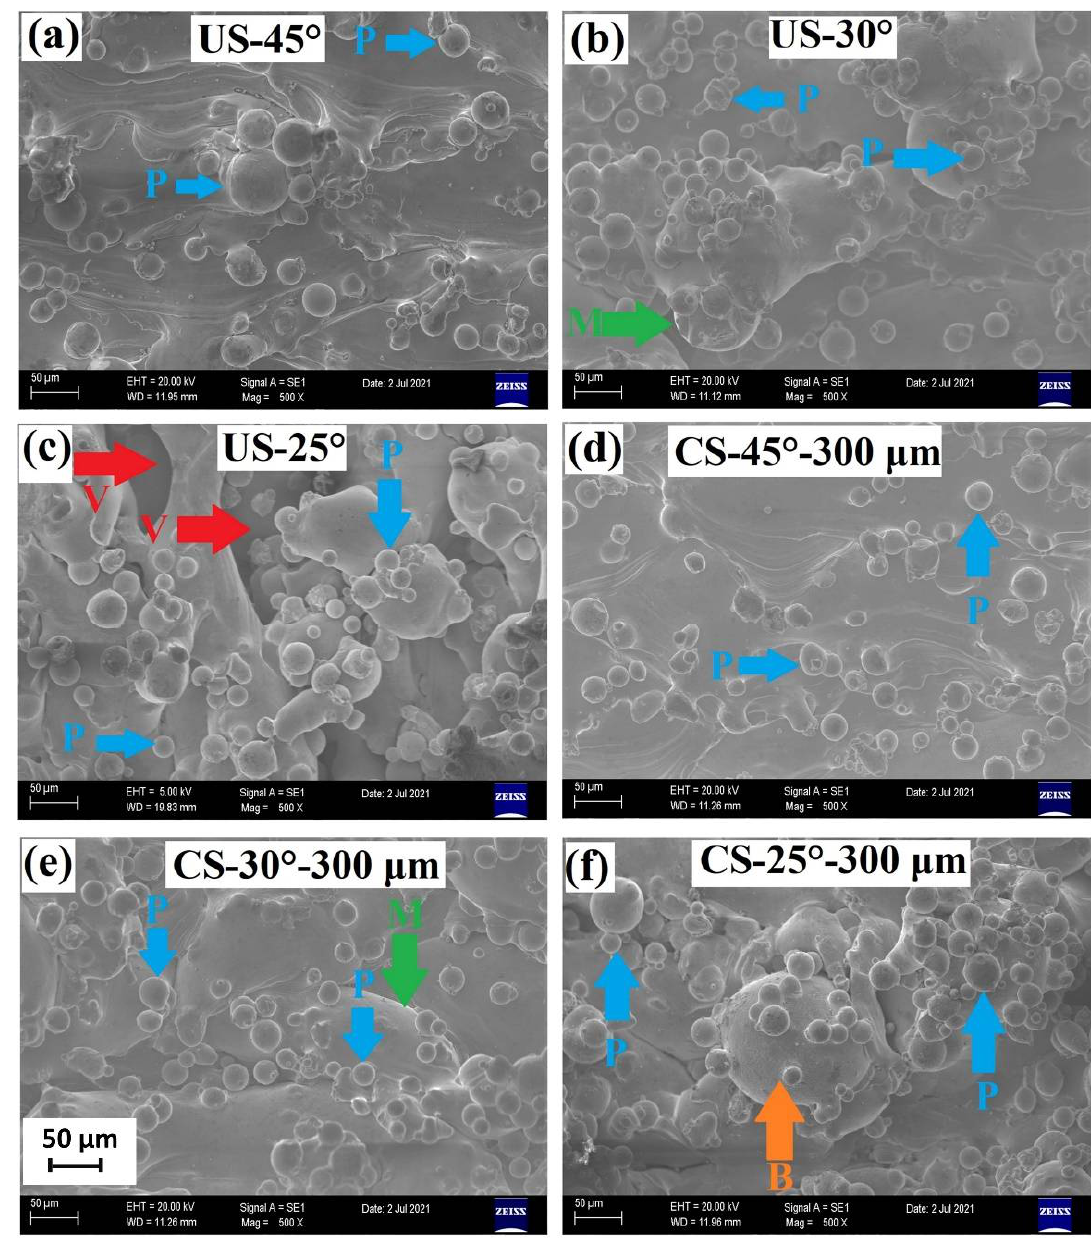
Figure 7. SEM images taken from the overhang surfaces of the samples (z-projection): ( a ) US-45°,